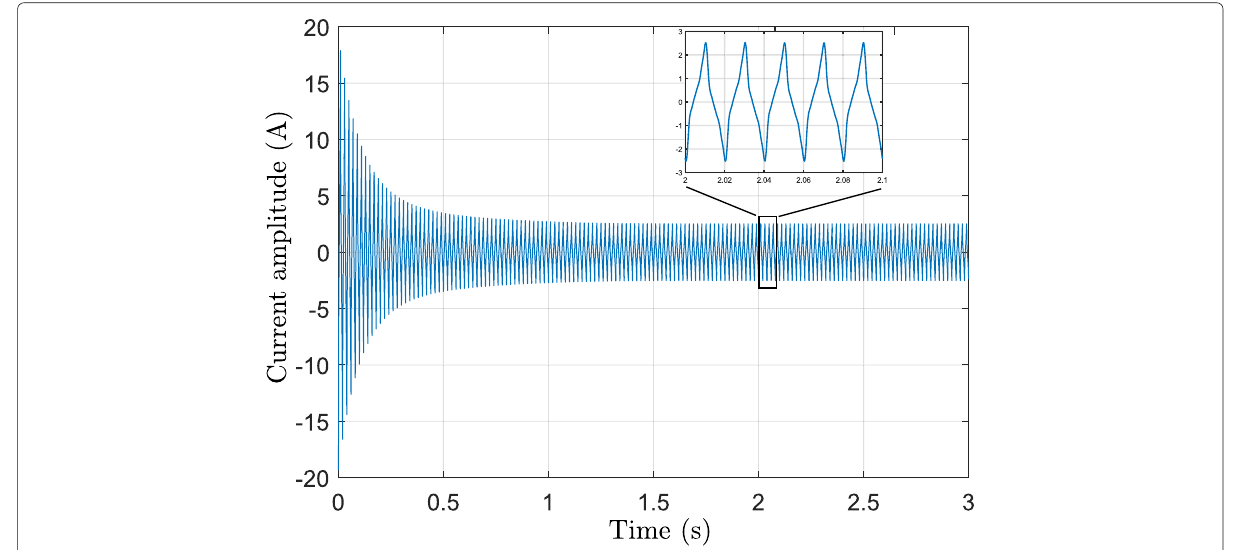
Fig. 5 Simulated turn-on transient current used for performance